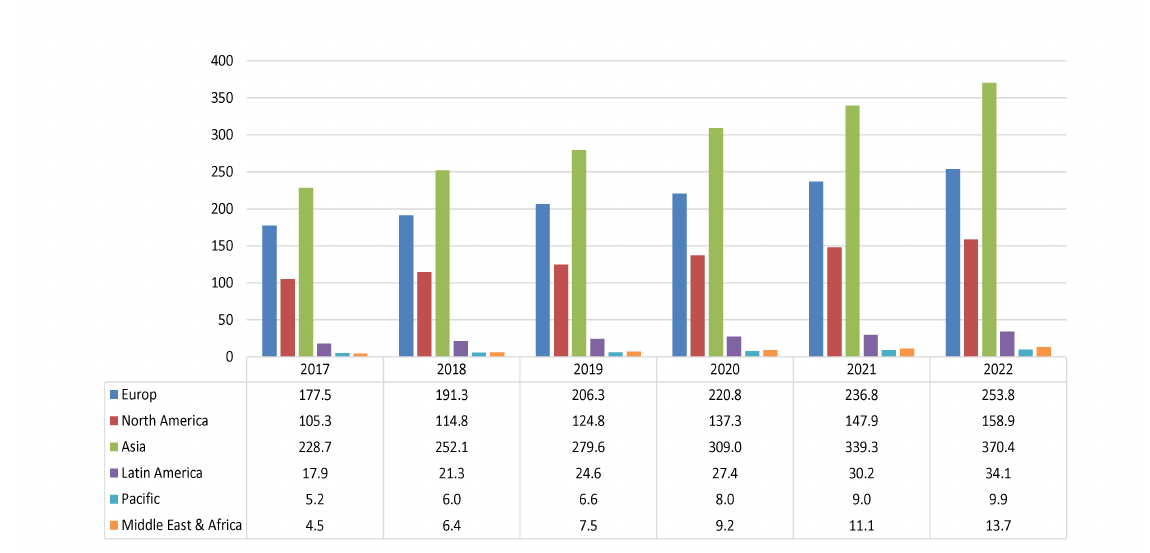
Figure 1. Cumulative wind energy market forecast by region 2018-2022 (GW)